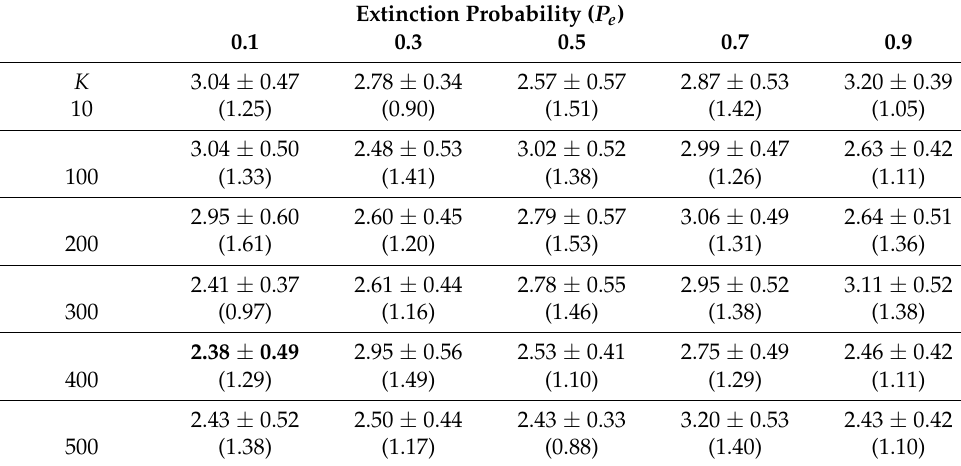
Table 6. Fitness results of SDEP with targeted extinction on Rastrigin ( K is the stagnant counter and fitness threshold T = 0.5); 95% confidence interval is presented after ± sign, and standard deviation is presented inside parenthesis. Minimum results are in bold font.